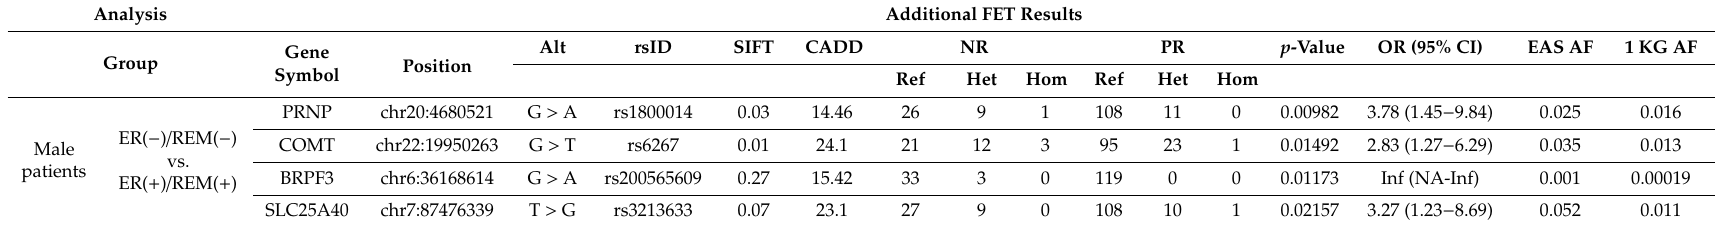
Table 3. Significant variants in candidate genes for later non-remission in depressive patients exhibiting poor early